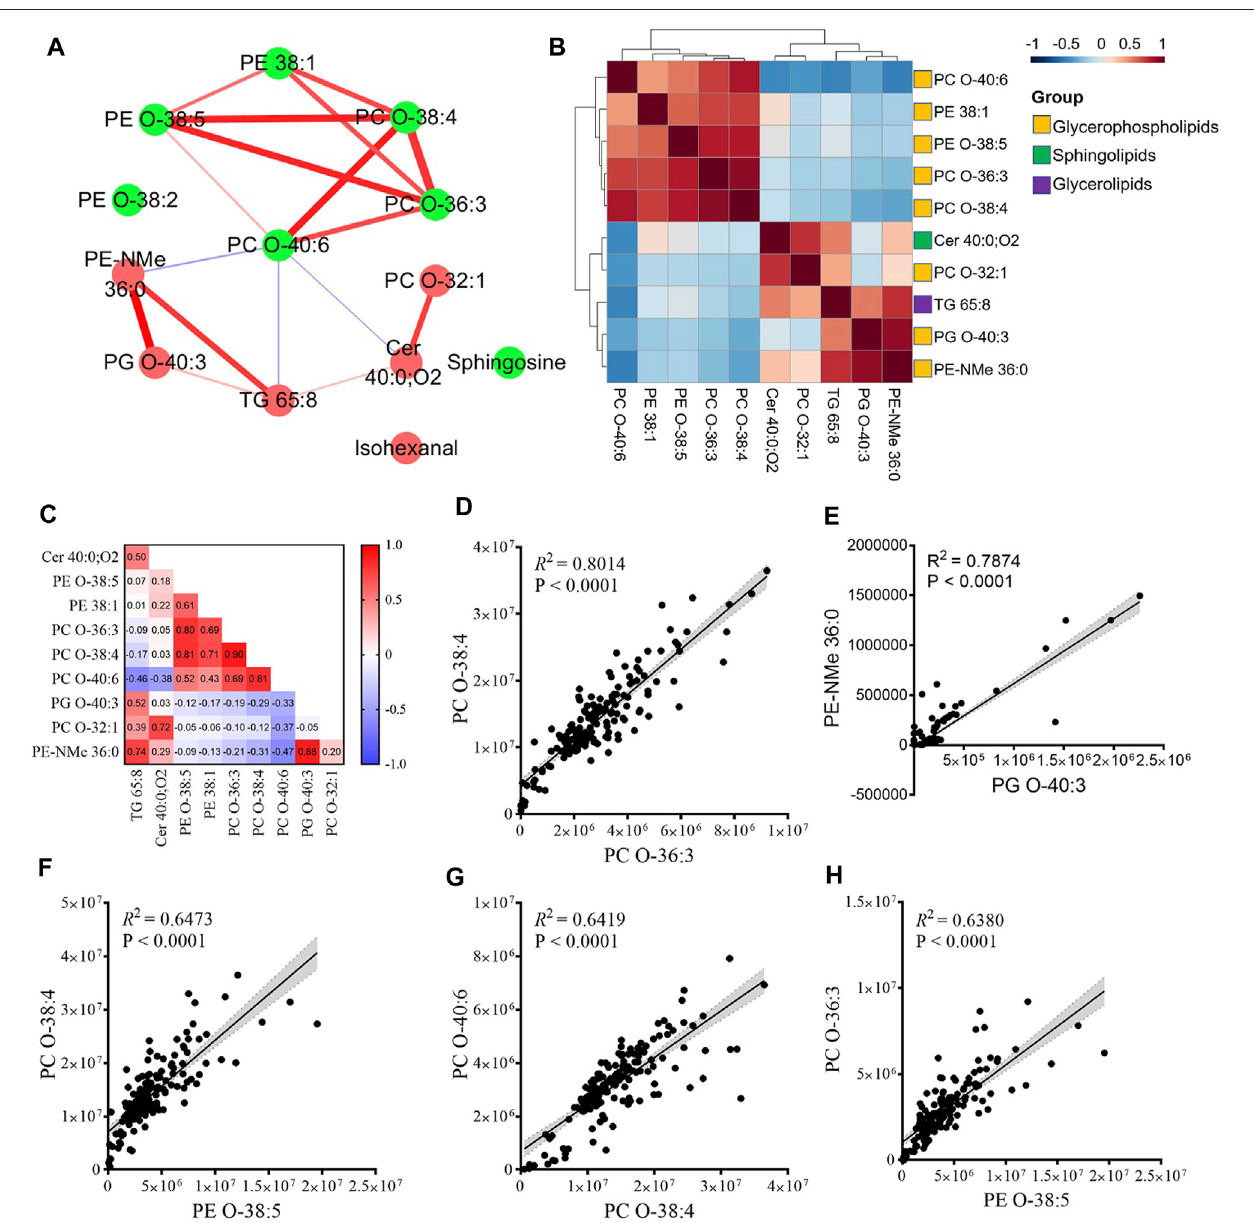
FIGURE 4 | Functional metabolite groups altered in women with PROM in early pregnancy. (A) The correlation network of the altered metabolites in PROM. The node represents a compound, and each edge represents the strength of correlation between two compounds. Edge weights represent Pearson ’ s correlation coef fi cients. The red/green nodes represent upregulated/downregulated metabolites in the PROM cohort. The red/blue edges indicate positive/negative correlations between two metabolites. (B,C) Correlation matrix colored by the Pearson correlation coef fi cient ( r ) of each pair of PROM-related compounds across samples. (D – H) The linear model of top fi ve highly correlated ( R 2 > 0.6) pair of PROM-related metabolites. The 95% con fi dence interval for the linear regression is represented by the gray